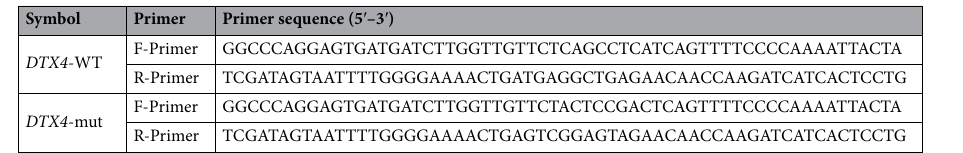
Table 2. Primer sequences.